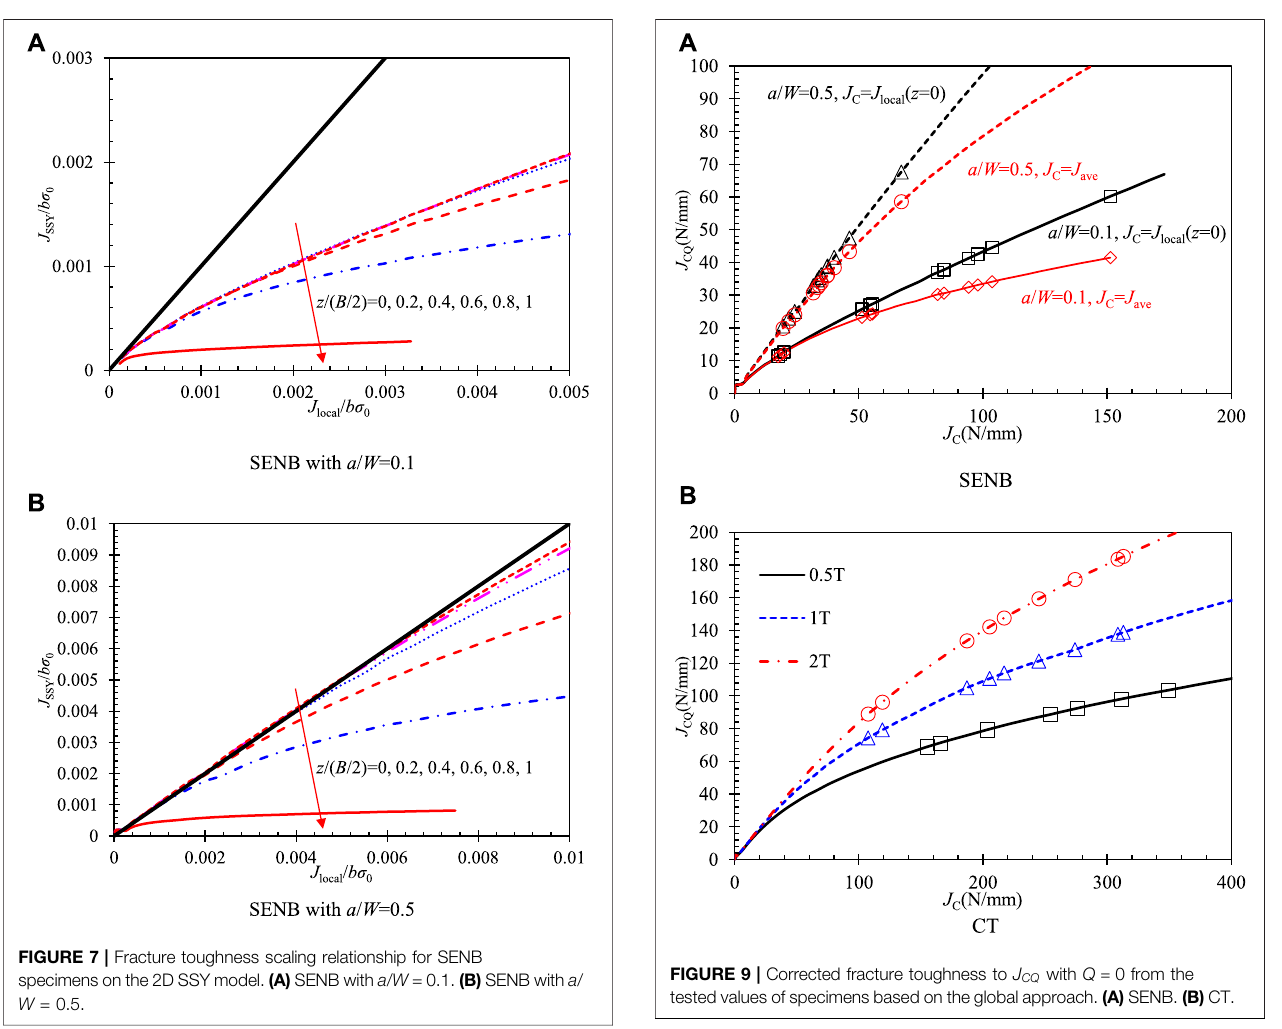
Frontiers in Materials |